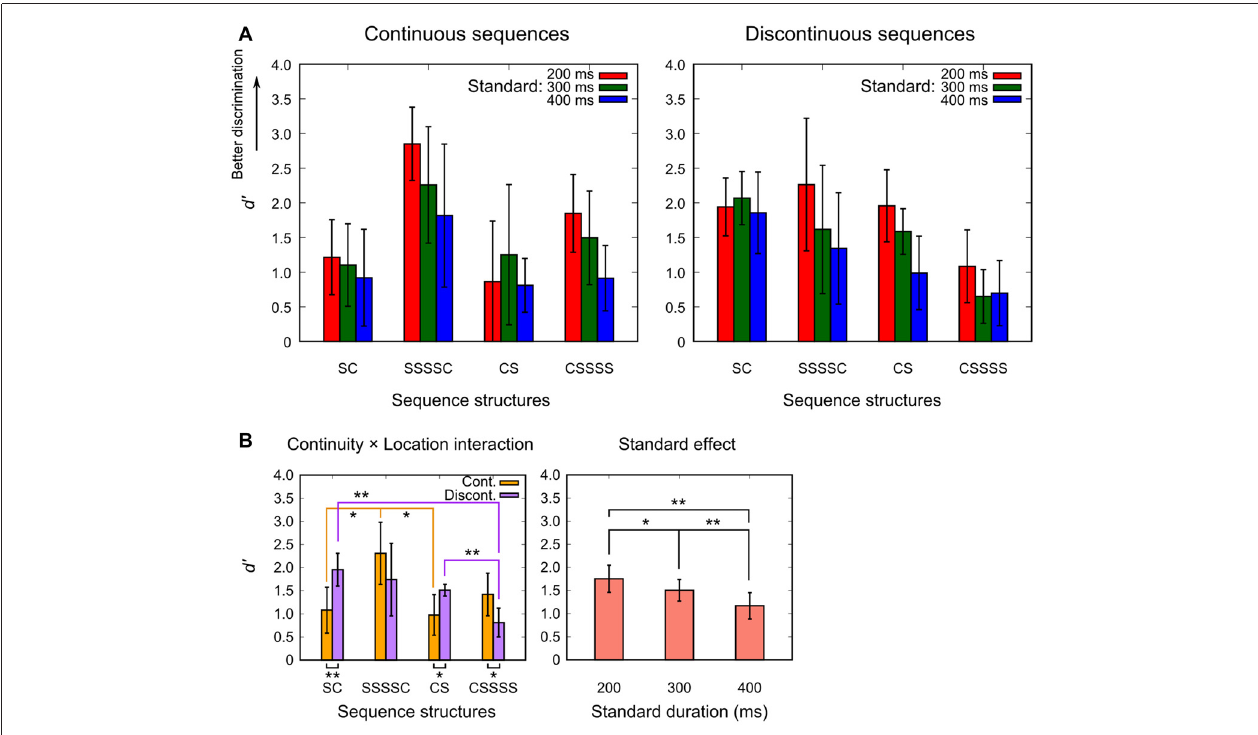
FIGURE 3 | Mean d (cid:48) for each experimental condition of the location-varied session (A) , and the results of the post hoc contrasts for the continuity × location interaction and the standard effect that were significant in the omnibus analysis of variance (ANOVA) (B) . Bars represent 95% confidence intervals. Asterisks indicate significant differences ( ∗ p < 0.05, ∗∗ p <